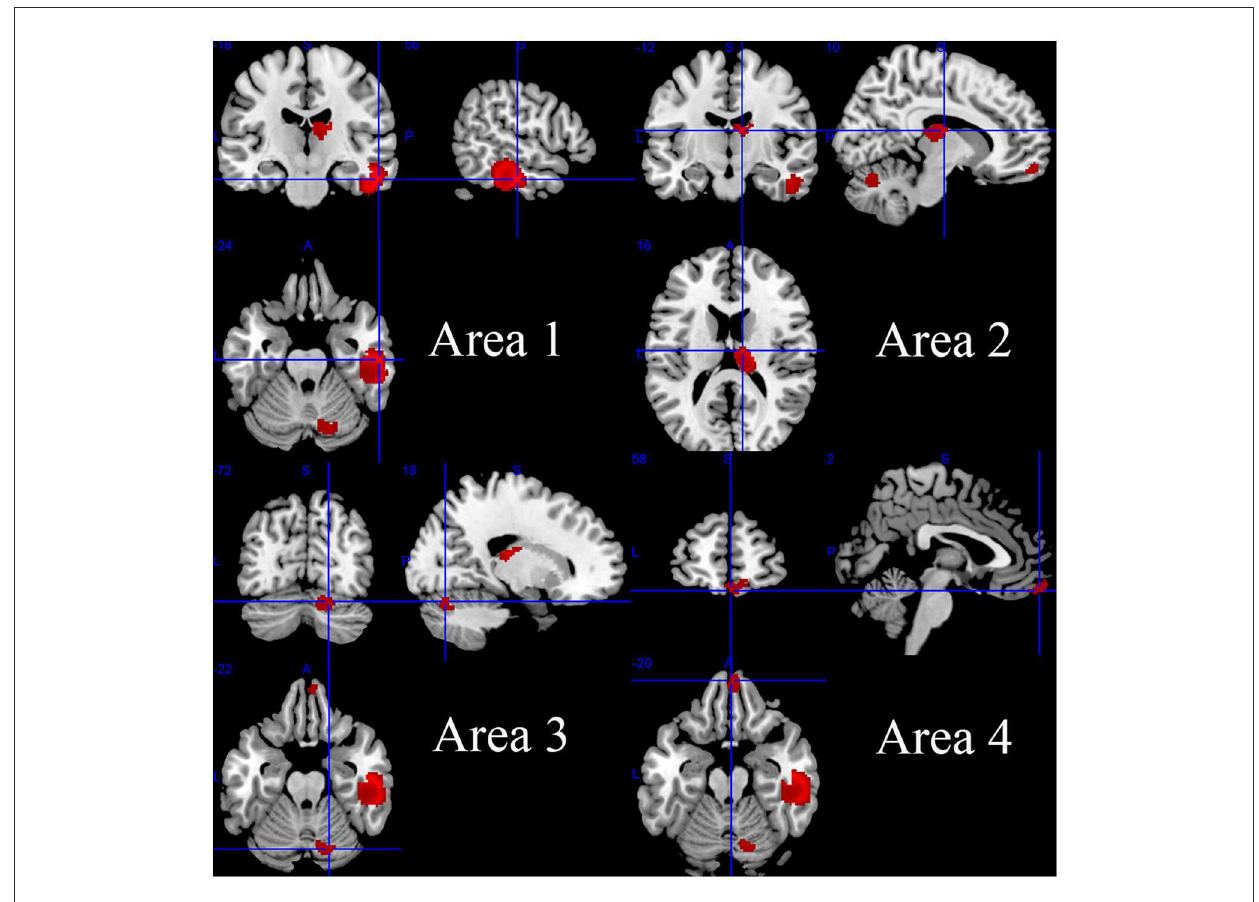
FIGURE2 Regions of increased intrinsic resting-state brain activity in patients with